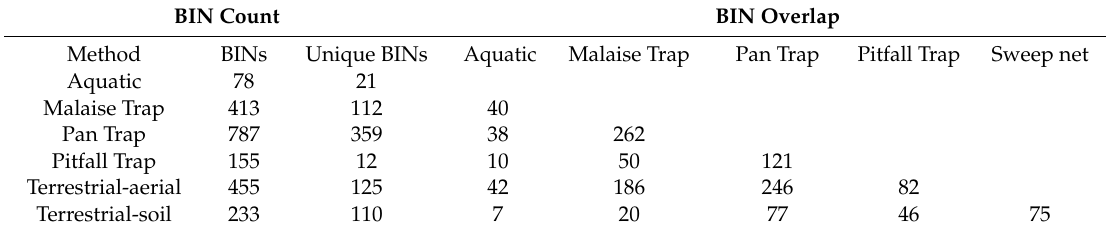
Table 3. Number of BINs recorded with each collecting method and the overlap (shared BINs) between